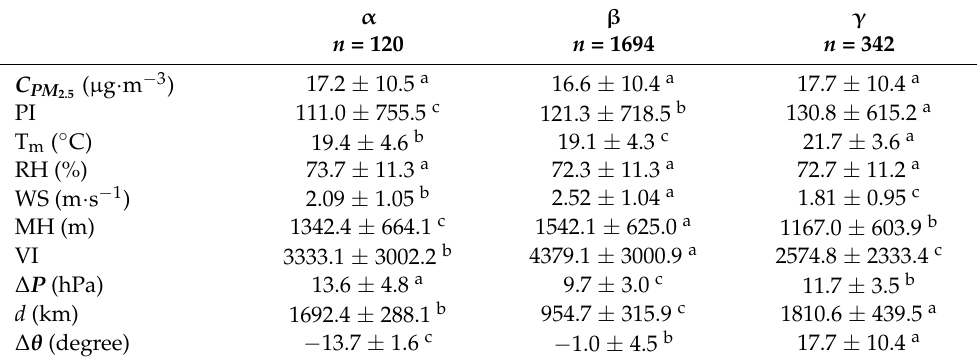
Table 3. Mean PM 2.5 concentrations ( C PM ) and major parameters in the Taipei metropolis during 2.5 winter from 2015 to 2020, when the centres of the continental high-pressure systems were in regions α , β , and γ